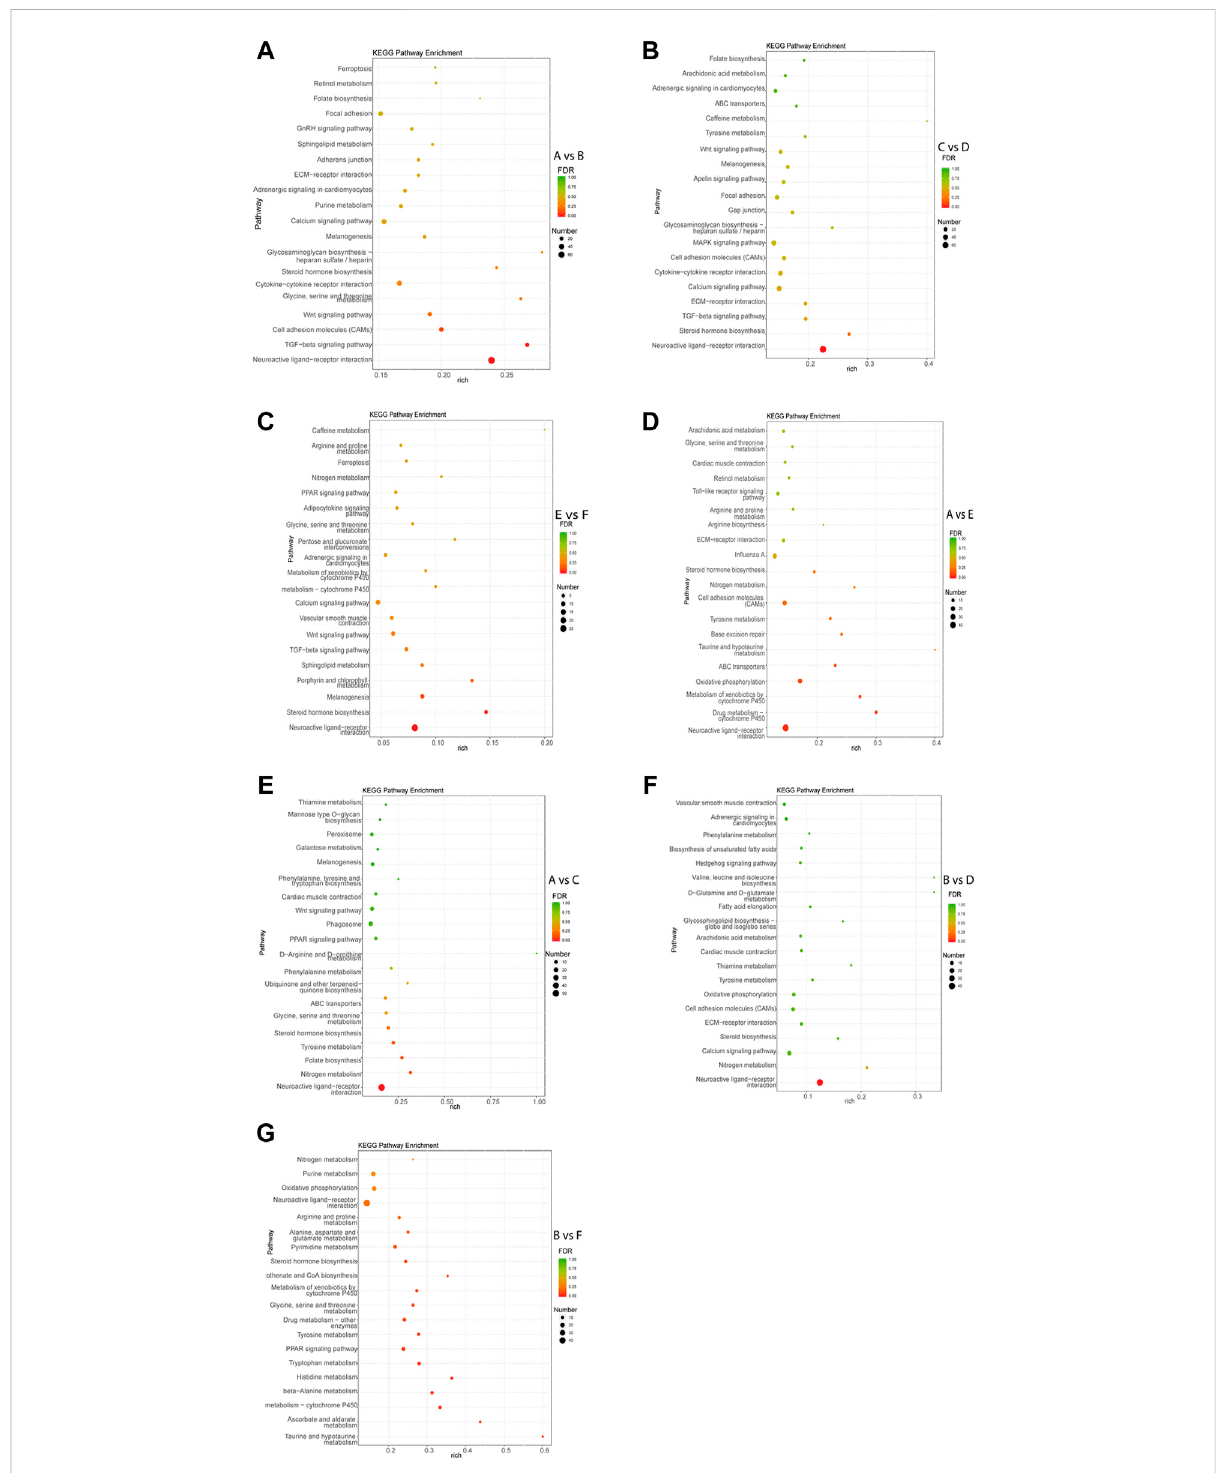
FIGURE 3 Top 20 pathways enriched with DEGs by KEGG pathway enrichment analysis. The Rich factor of x -axis is the ratio of the number of DEGs enriched in the pathway to the number of all annotated genes in the pathway. The size of the circle indicates the number of DEGs enriched in the pathway. The FDR (false discovery rate) indicates the enrichment degree of DEGs in a certain pathway. The closer to zero the FDR, the higher the enrichmentdegree.Intra-breedcomparisonsbetweenfemalesandmalesincludeAvs.B. (A) ,Cvs.D. (B) ,andEvs.F. (C) .Comparisonsbetween Mule ducks and Muscovy ducks or Jinding ducks of same sex include A vs. E. (D) , A vs. C. (E) , B vs. D. (F) , and B vs. F. (G)